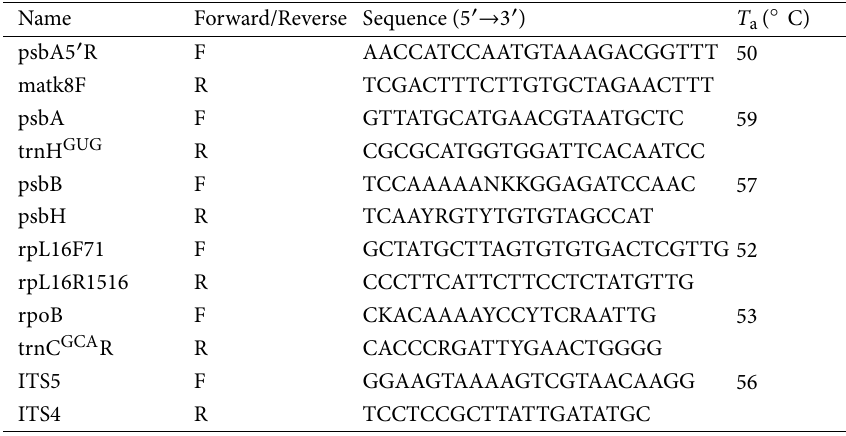
Table 1 Description and amplification conditions of the six primer pairs (five chloroplast and one nuclear) used for the molecular